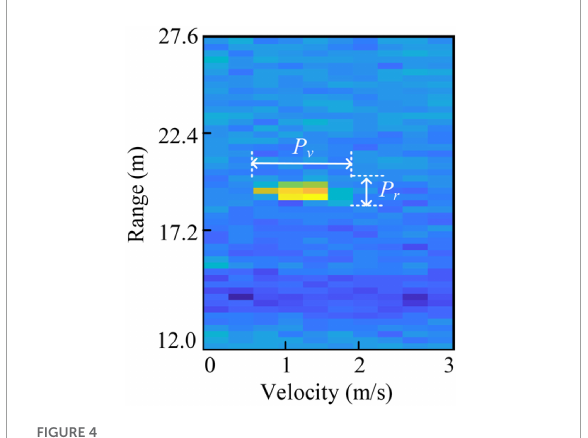
FIGURE4 The schematic diagram of P r and P v